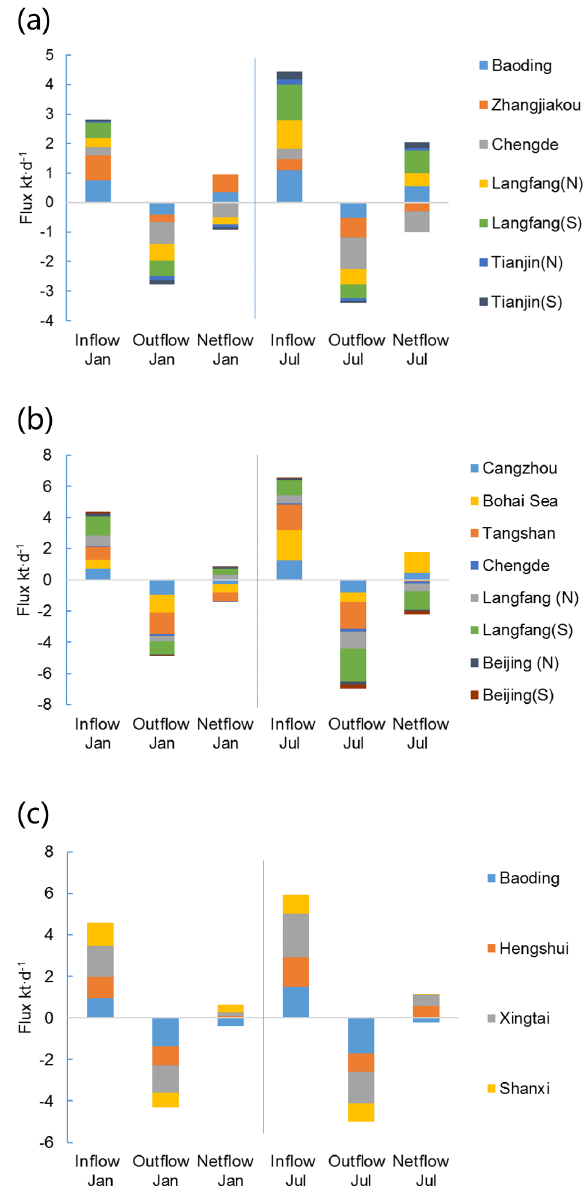
Figure 4. The inflow, outflow and net fluxes in January and July for (a) Beijing, (b) Tianjin and (c)